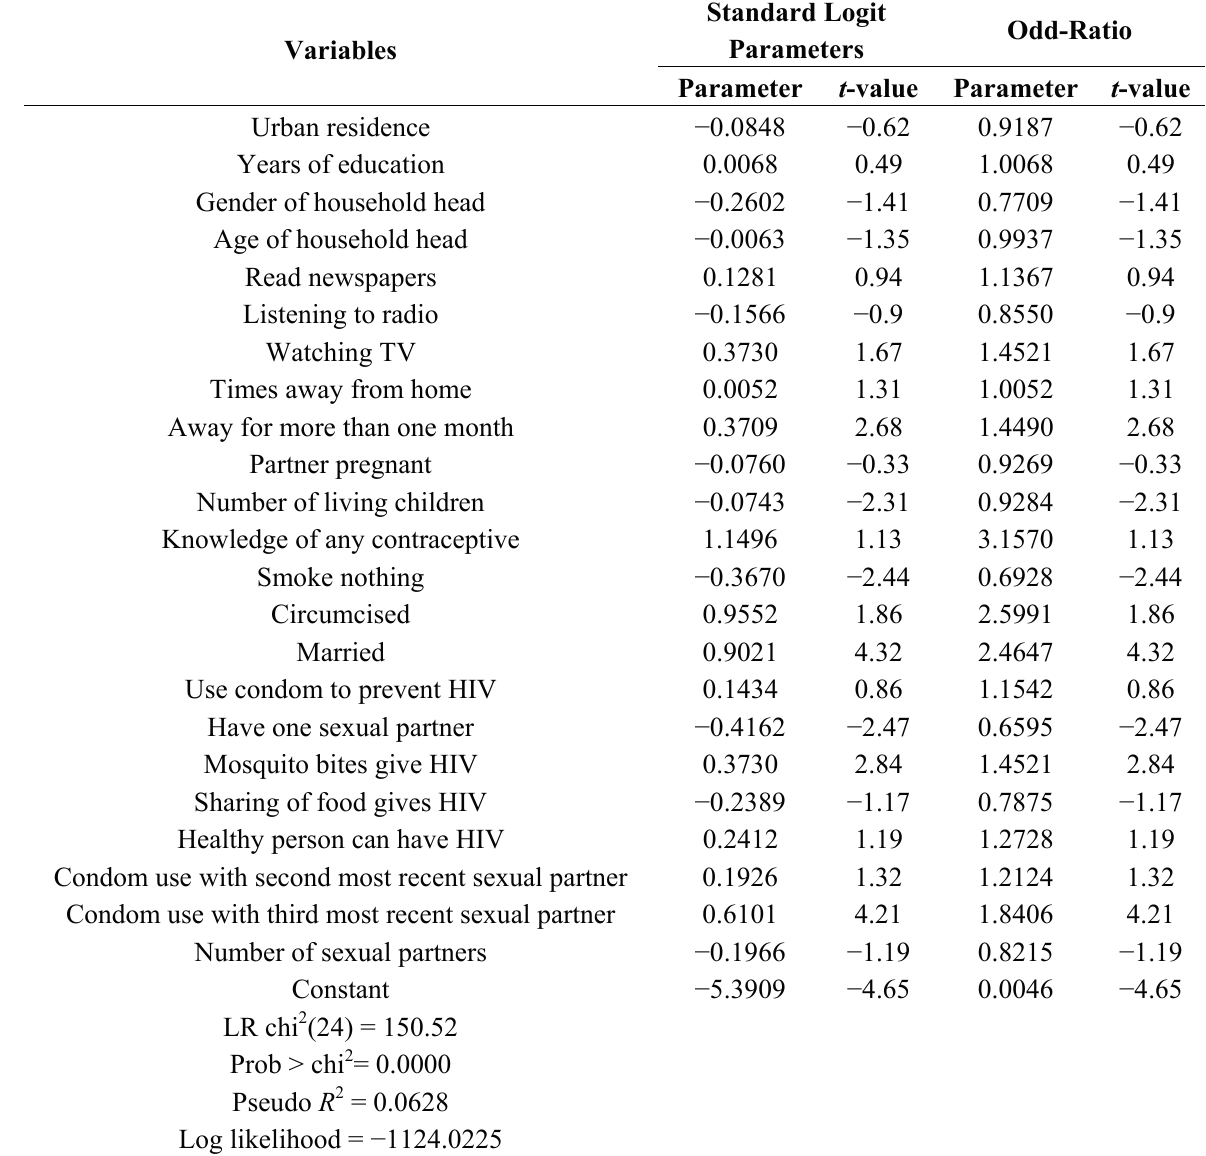
Table 4. Logistic Regression Results of Factors Influencing Morbidity with